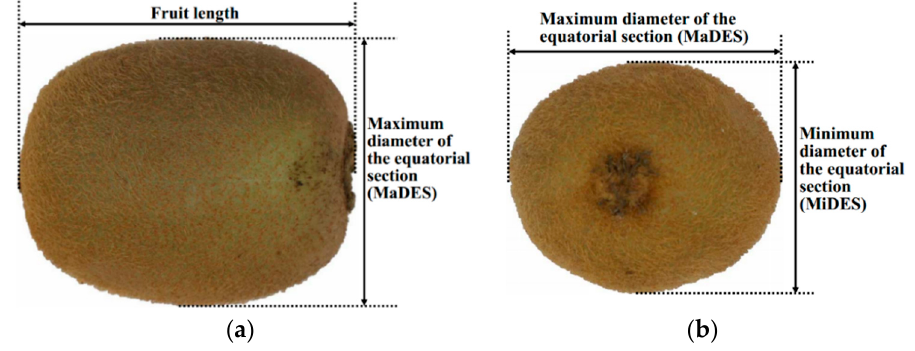
Figure 1. Definitions of fruit length, maximum diameter of the equatorial section (MaDES), and minimum diameter of the equatorial section (MiDES). ( a ) Top view of a kiwifruit; ( b ) Side view of the kiwifruit.